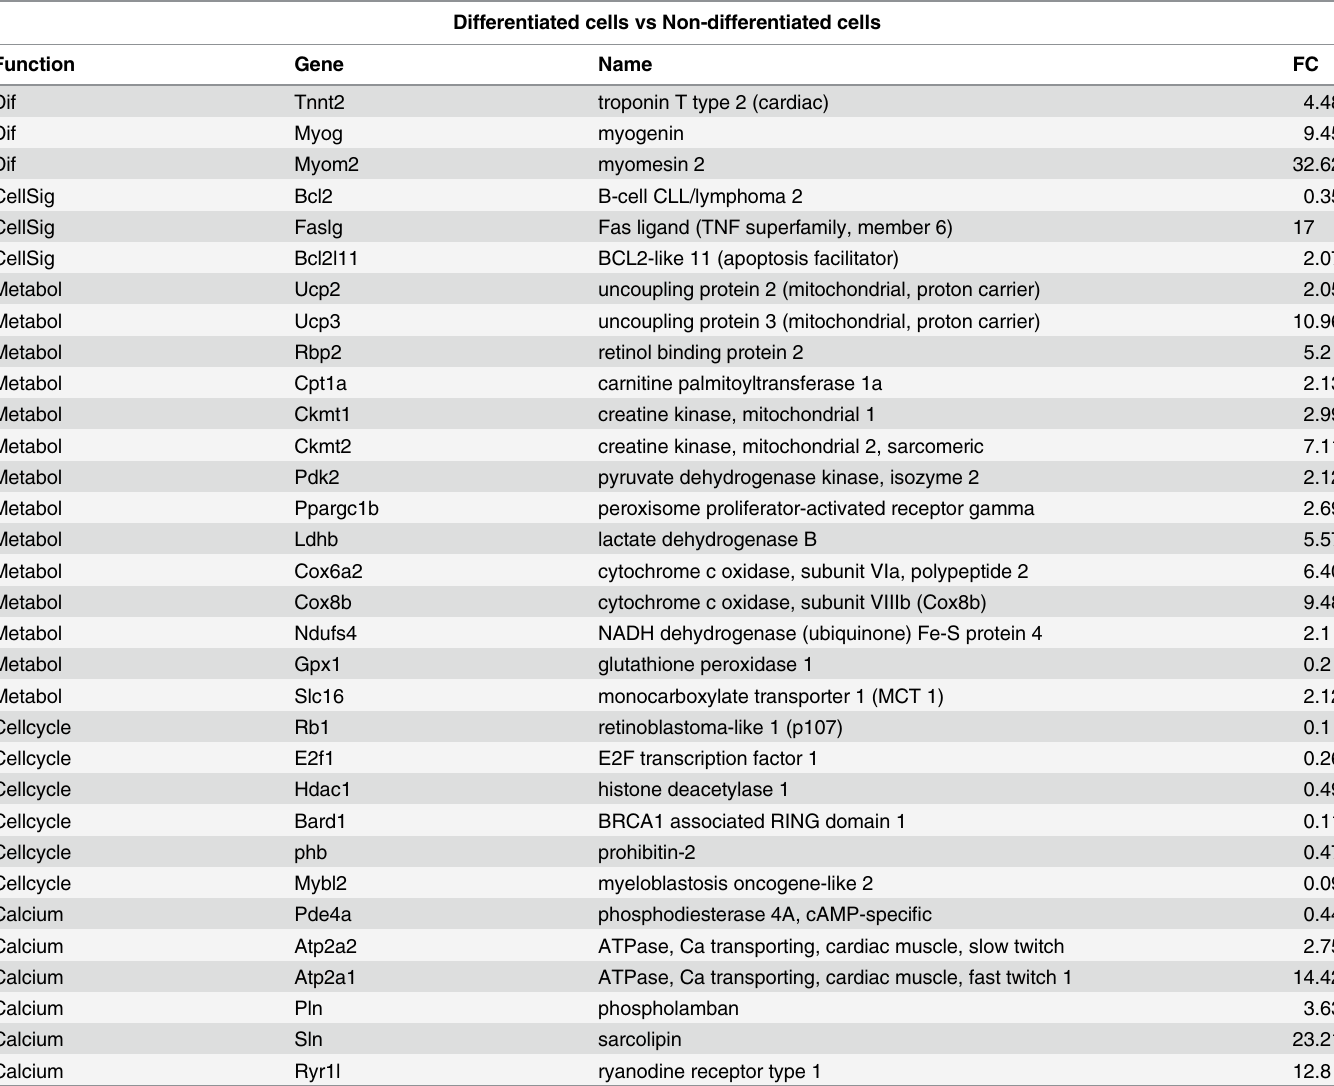
Table 2. Most relevant differences in terms of gene expression in H9c2 undifferentiated myoblasts vs RA-differentiated H9c2 cells. Differentiated cells vs Non-differentiated